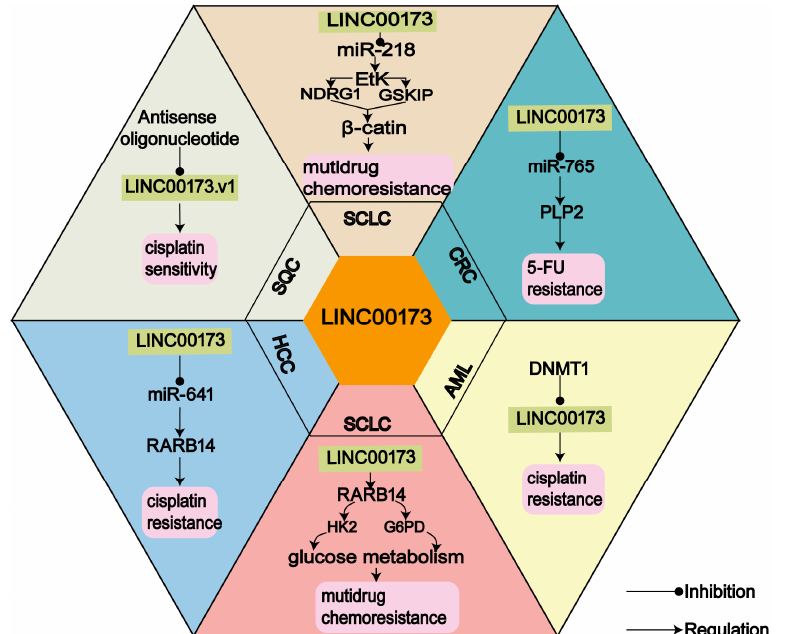
Figure 1. The biological function of LINC00173 in chemoresistance. LINC00173 regulates drug re- sistance in 6 human cancers, including AML, SCLC, HCC, CRC, and SQC.